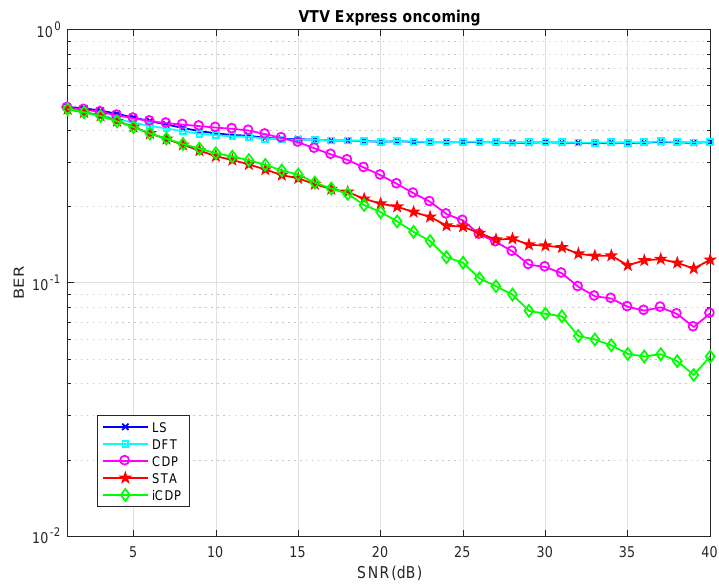
Figure 7. Vehicle-to-Vehicle (VTV) Express oncoming Channel, Data Symbols =